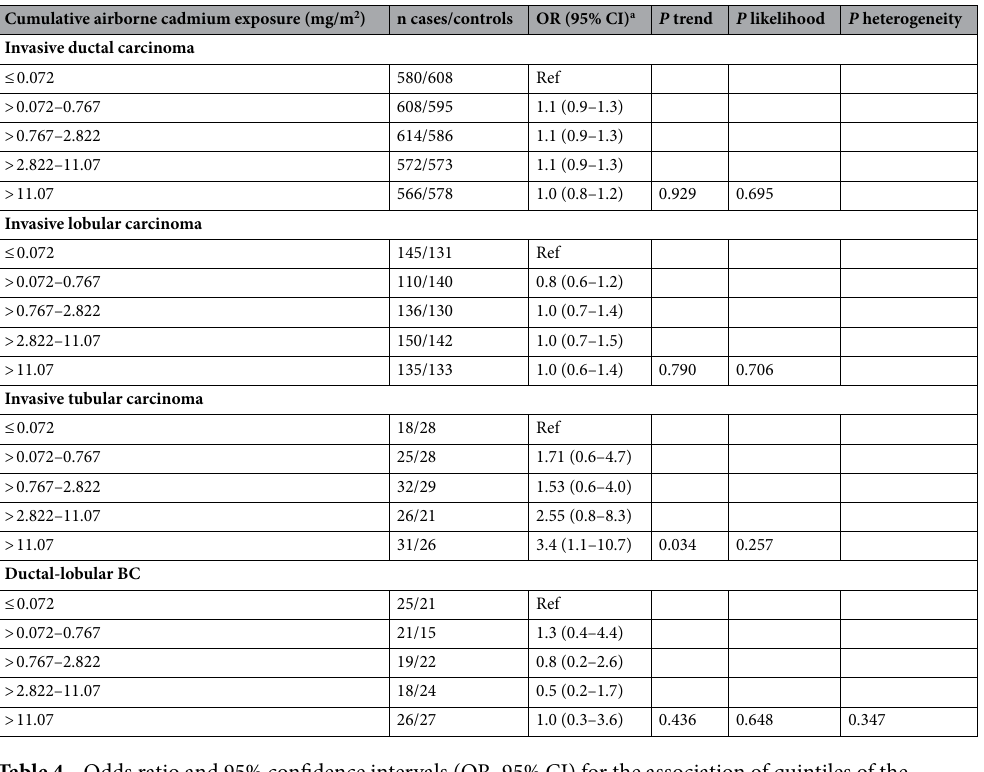
Table 4. Odds ratio and 95% confidence intervals (OR, 95% CI) for the association of quintiles of the cumulative airborne cadmium exposure with risk of breast cancer according to the histological type in the case–control study nested within the E3N cohort, France, 1990–2008. a Multivariable models were adjusted for physical activity, tobacco smoking status, alcohol intake, level of education, body mass index, age at menarche, age at first full-term pregnancy, parity, breastfeeding, oral contraceptive use, menopausal hormone replacement therapy use, status of birthplace, previous family history of breast cancer and personal history of benign breast disease. P likelihood: P-values from likelihood ratio test comparing the statistically significance of the global effect of the quintiles. P heterogeneity: comparing heterogeneity of associations across histological type of breast